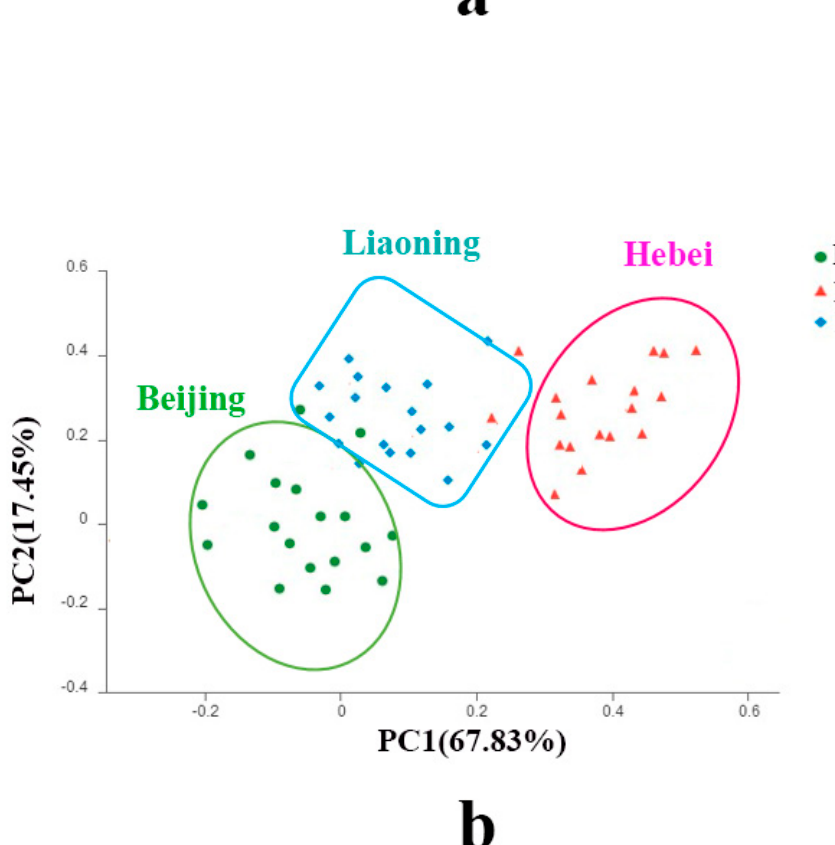
Figure 4. Principal coordinates analysis (PCoA) based on the relative abundance of fungal OTUs showing the fungal community structure: ( a ) in different organs and soil of Jingbai pear trees; ( b ) in different sites.